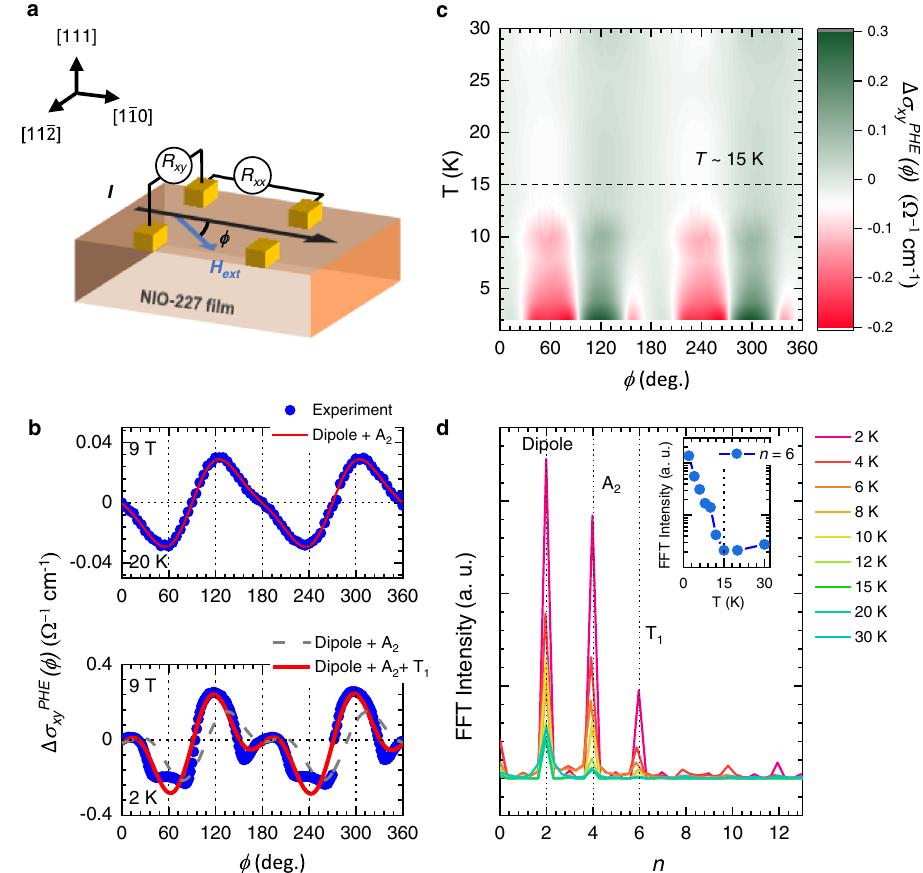
Fig.3|Anomalousmagneticoscillationinthe Δ σ PHE xy ð ϕ , H = ± 9 T Þ oftheNIO-227 thin fi lm. a Schematic diagram of the Δ σ PHE xy ϕ ð Þ measurement geometry. In this (cid:1) (cid:3) geometry, I isappliedalongthe 1 (cid:1) 10 directionand H ext isrotatedwithinthesample plane. b Δ σ PHE xy ϕ ð Þ curves at 20 and 2K. At 20K, the Δ σ PHE xy ϕ ð Þ curve has a sin (2 ϕ ) oscillation.At2K,the Δ σ PHE xy ϕ ð Þ curvehasaninhomogeneousoscillation,indicating a hidden magnetic origin. c Contour plot of all Δ σ PHE xy ϕ ð Þ curves below 30 K.